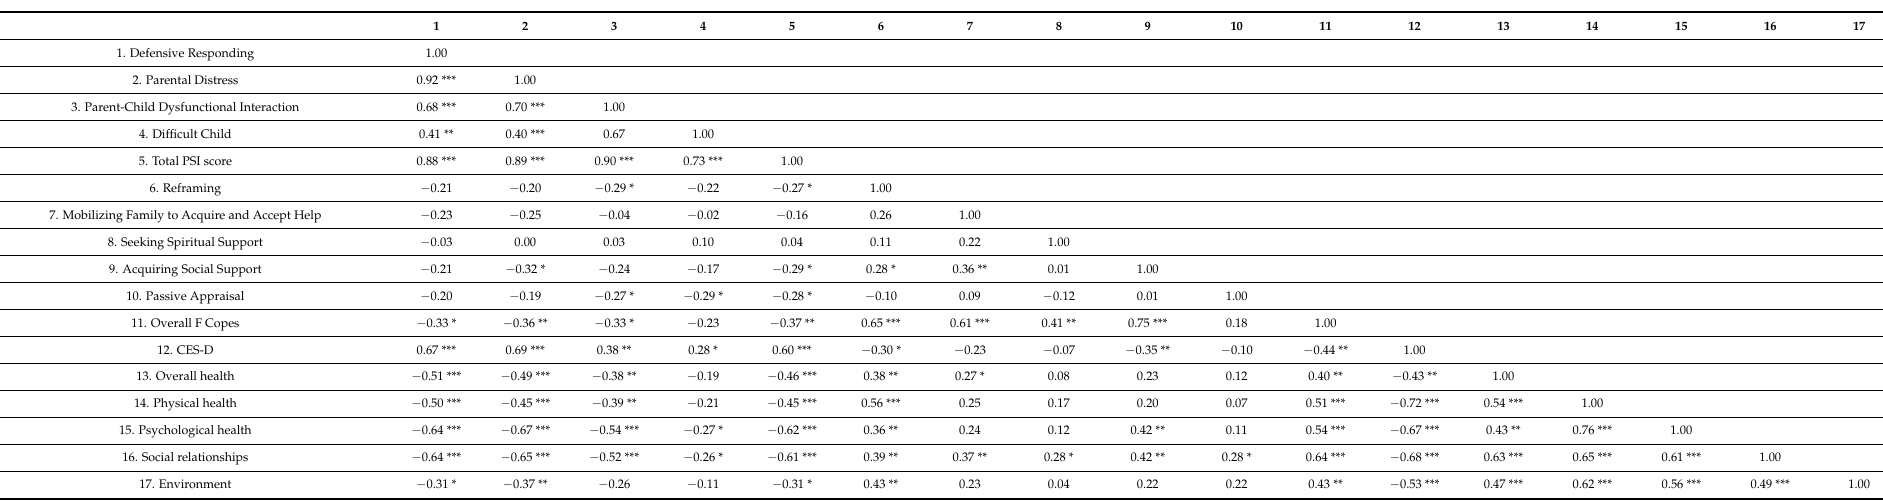
Table 3. Pearson’s correlation coefficients among all understudy scales during the COVID-19